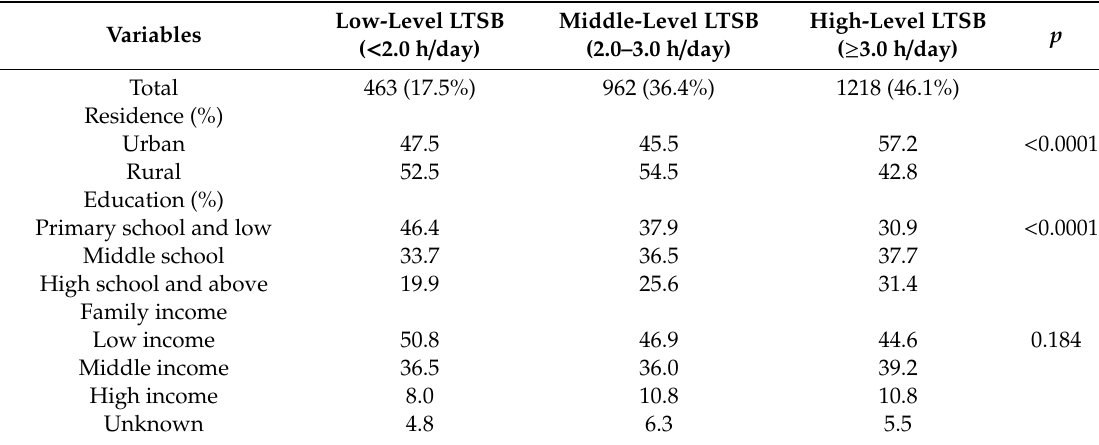
Table 1. Basic characteristics between middle-aged women with di ff erent leisure-time sedentary behavior (LTSB)